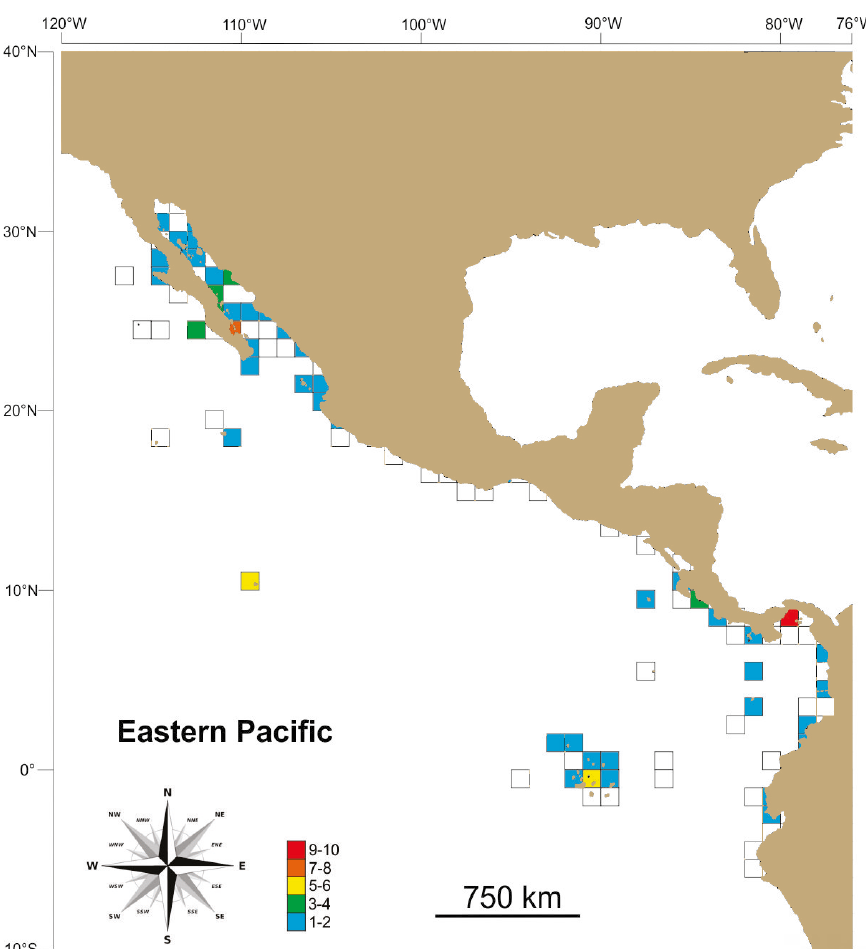
Figure 4. Species richness of narrow-distributed (1-2 grids) marine benthic caridean shrimps per grid (1° latitude by 1° longitude) in the Eastern Tropical Pacific. Notice color scale.